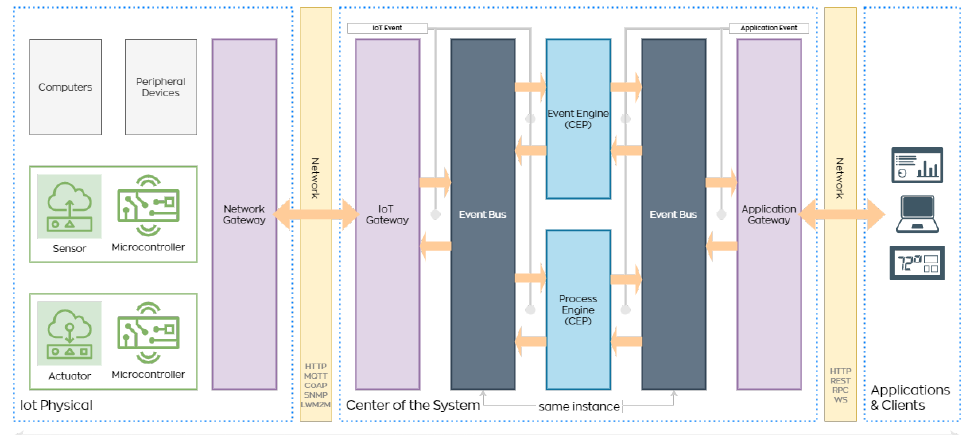
Figure 1. Architecture